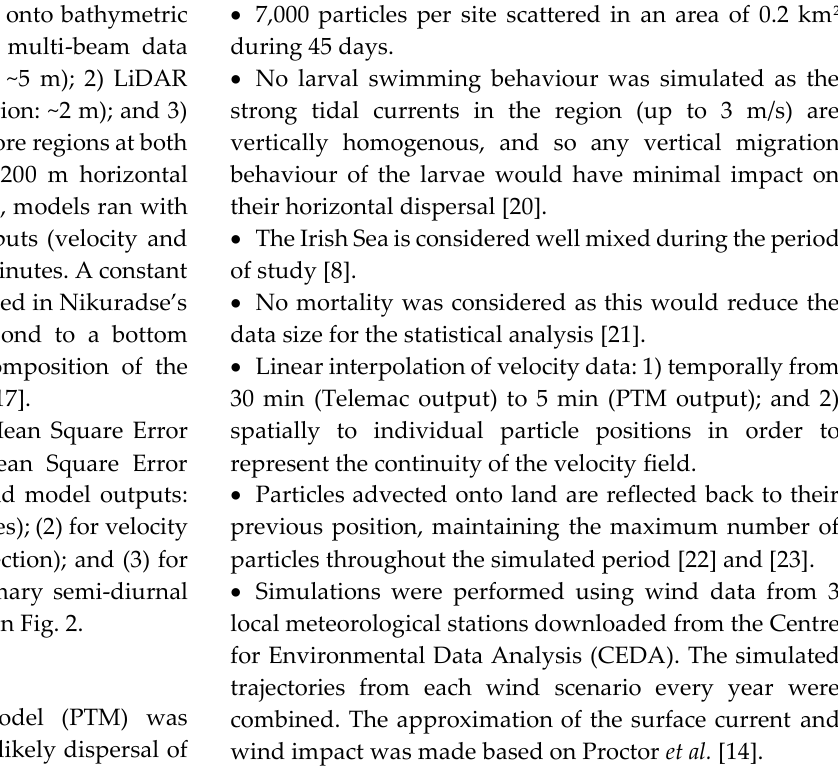
Fig. 2. Contour map showing the simulated residuals (m/s) in the Irish Sea, using the model described here, with direction of the main residuals plotted (black arrows). Tide gauge sites (red, black and blue squares) and ADCP velocity sites (green triangles) used for model validation are